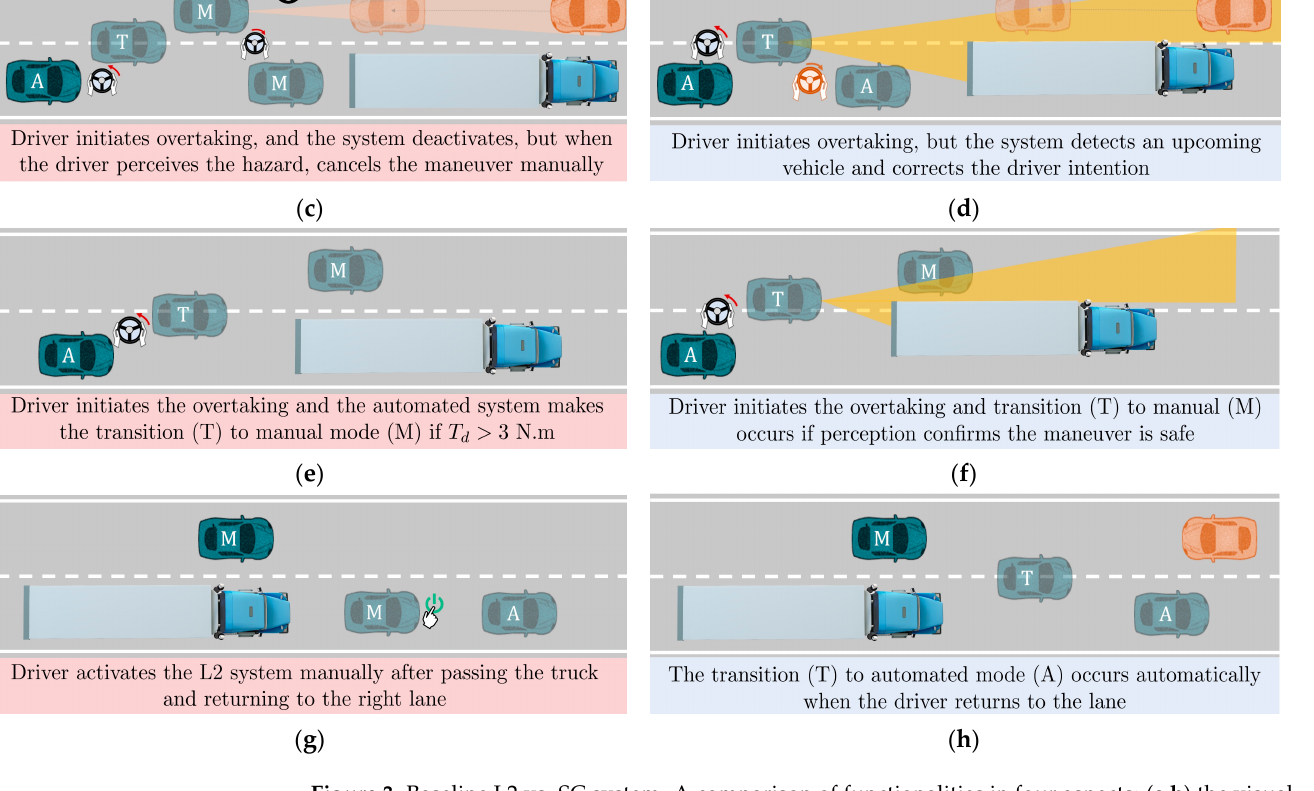
Figure 3. Baseline L2 vs. SC system. A comparison of functionalities in four aspects: ( a , b ) the visual HMI interaction, ( c , d ) the correction maneuver, ( e , f ) the transition from automated to manual, and ( g , h ) the transition from manual to automated.